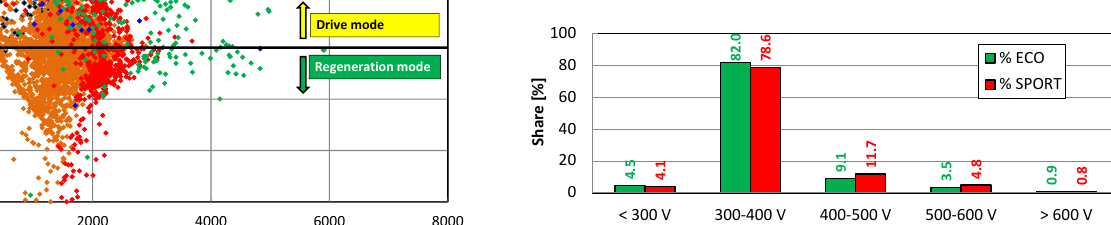
Fig. 15. The inverter voltage values in the RDE drive test in two vehicle modes: a) ECO, b) SPORT Full analysis of the above results indicates that the vol- tage value in the 300–400 V range occurs 80% of the time (Fig. 16). These values are similar in both driving modes.